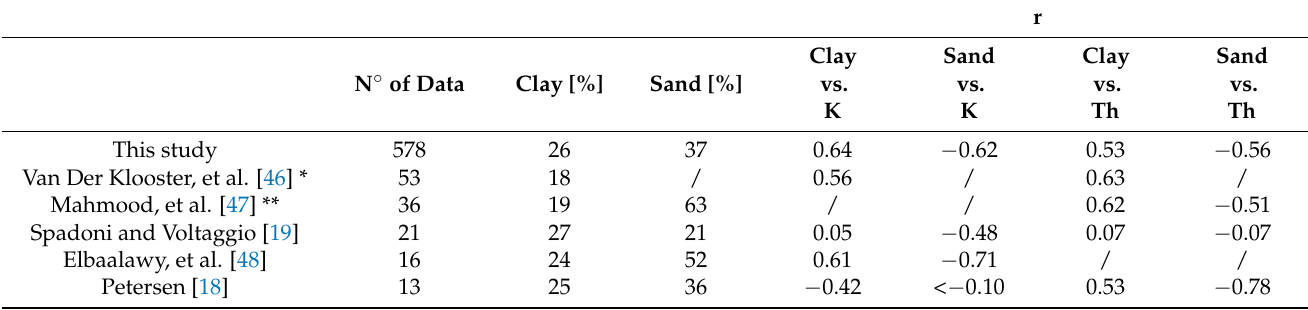
Table 2. Comparison of the Pearson correlation coefficient (r) found in this study with the results of similar surveys for which the mean clay and sand contents of the investigated soils are reported together with the number of analyzed data. N ◦ of Data Clay [%] Sand [%]